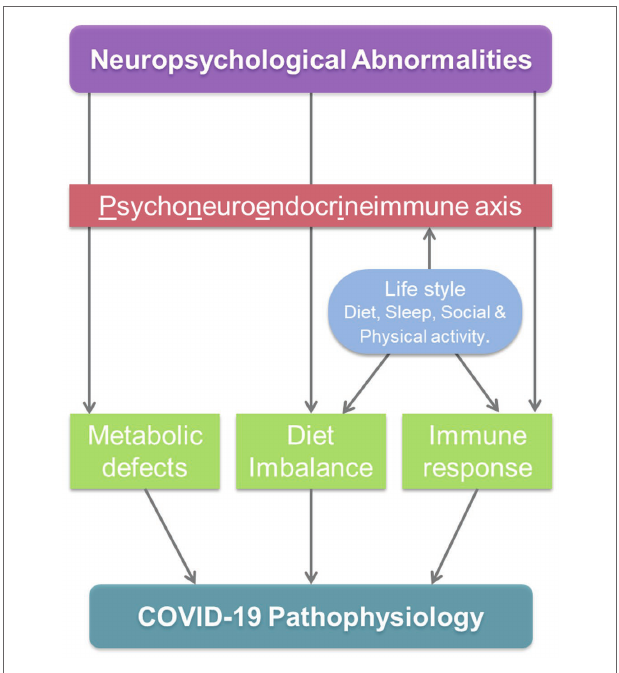
FIGURE 6 | Neuropsychological abnormalities can adjunct the COVID-19